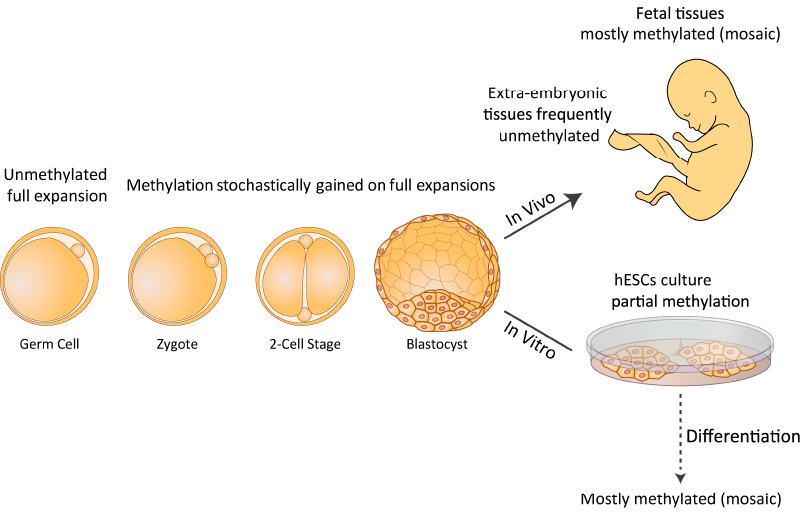
Figure 1. Model for timing and nature of fragile X mental retardation 1 (FMR1) hypermethylation in Fragile X syndrome (FXS) human embryonic stem cells (hESCs). Abnormal methylation is first achieved on full expansions in FXS at a restricted time point before/during embryo implantation. Once established, it is irreversible and is clonally maintained. CGG expansions that escape abnormal methylation during this limited time frame remain unmethylated or become further inactivated by a second wave of de novo methylation later during differentiation. Mostly methylated (mosiacism) means that some of the cells are methylated and that some are